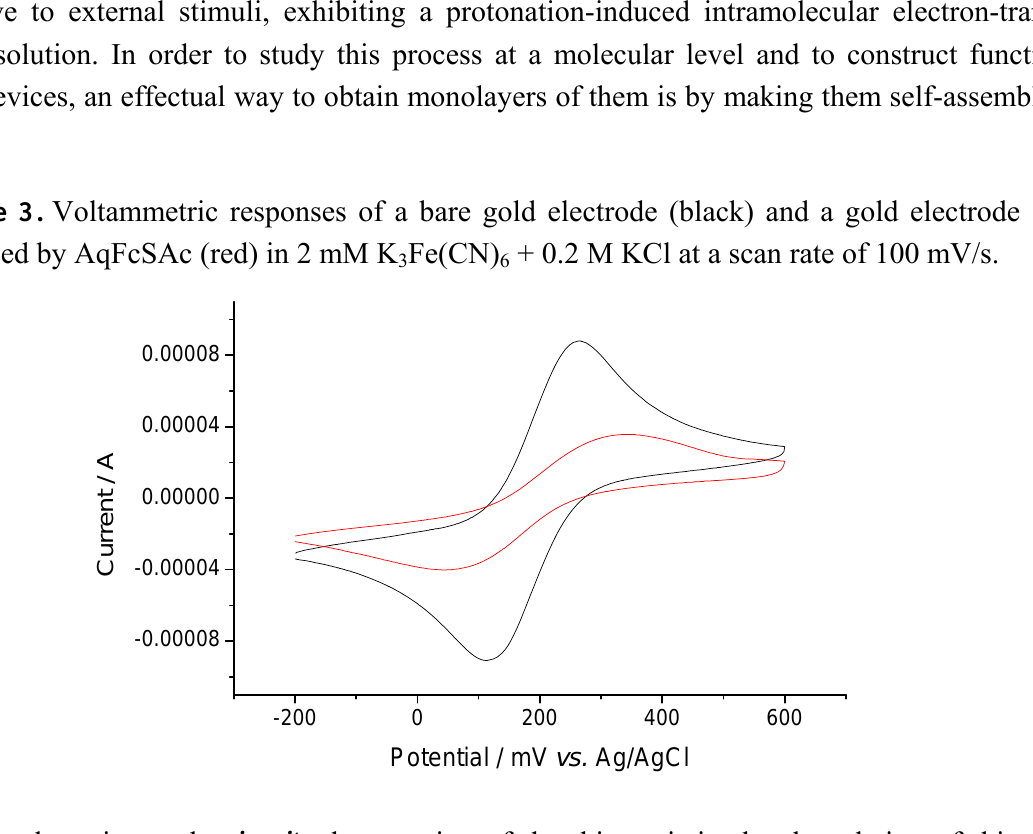
Figure 3. Voltammetric responses of a bare gold electrode (black) and a gold electrode modified by AqFcSAc (red) in 2 mM K